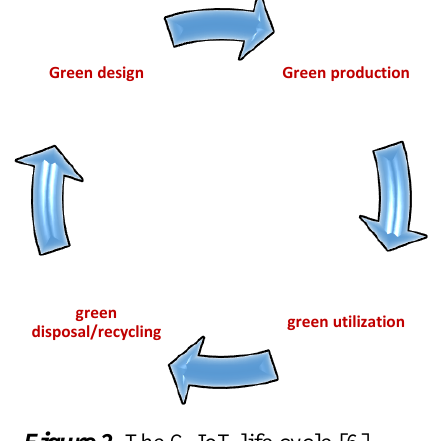
Figure 2. The G-IoT life cycle